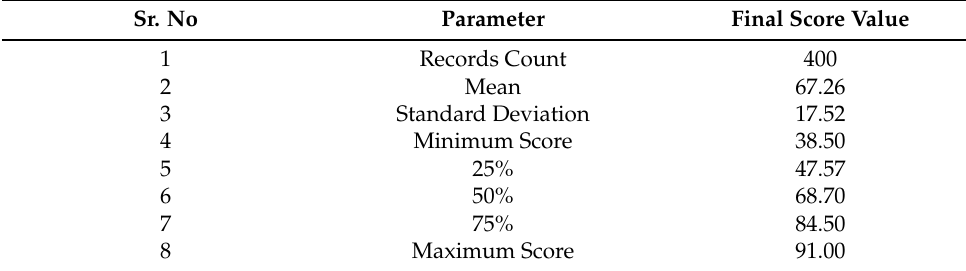
Figure 4. Final grades distribution—gender wise. ( a ) Academic criteria, ( b ) Technical criteria, ( c ) Examination criteria. Table 5. Dataset